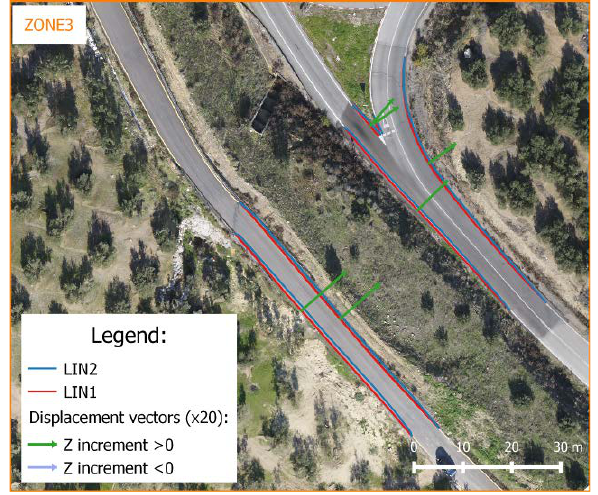
Figure 7. Displacement vectors (20x) from VIM-I in